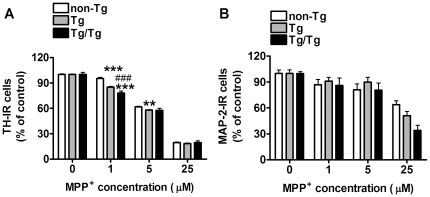
MPP+ effect on non-Tg, Tg and Tg/Tg neuron-enriched cultures.
A) MPP+ effect on TH-IR cell number in non-Tg (n = 18), Tg (n = 35) and Tg/Tg (n = 8) neuronal cultures. B) MPP+ effect on MAP-2-IR cell number in non-Tg (n = 18), Tg (n = 35) and Tg/Tg (n = 8) cultures. C) Two-way ANOVA followed by Bonferroni multiple comparison test: **P<0.01, ***P<0.001 vs respective non-Tg value; ###
P<0.01 vs respective Tg value.